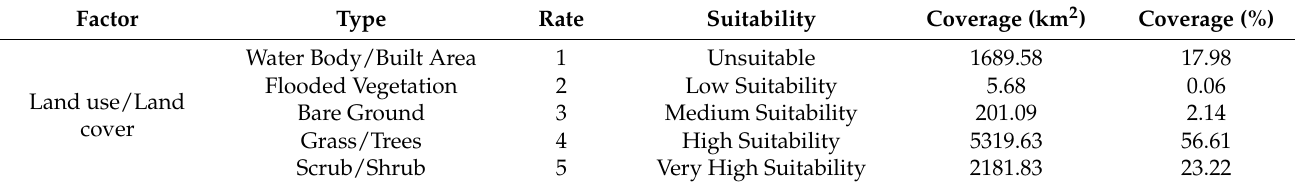
Figure 11. Land use/land cover and reclassified suitability map LULC ( left ); reclassified LULC ( right ). Table 5. Distribution of land use/ land cover suitability classes.